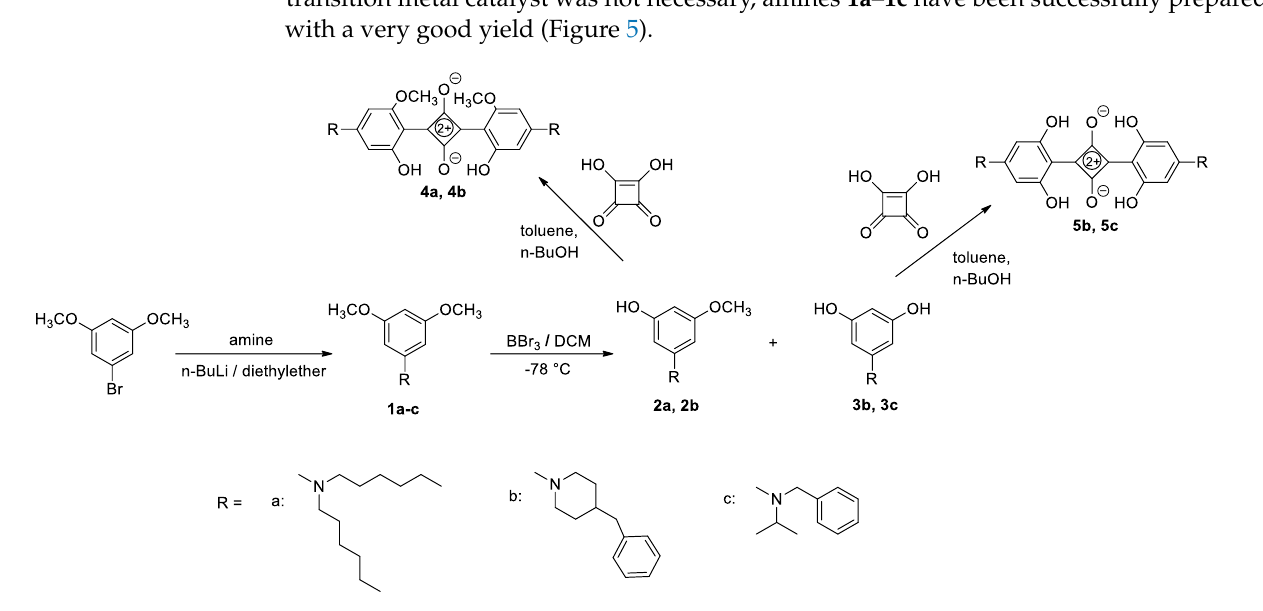
Figure 6. 1 H NMR spectra (CDCl 3 ) of compounds 1a – 1c .